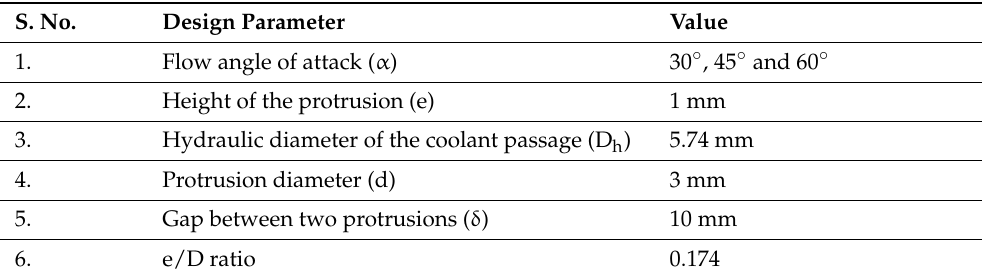
Table 3. Design parameters of the protrusion vortex generator.